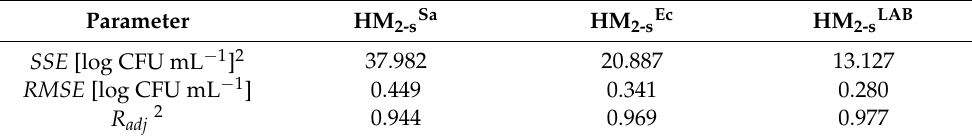
Table 2. Goodness-of-fit indices of the tertiary HM 2-S constructed through two-step data analysis for growth prediction of single cultures of S. aureus (Sa), E. coli (Ec), and Fresco (LAB) in milk.